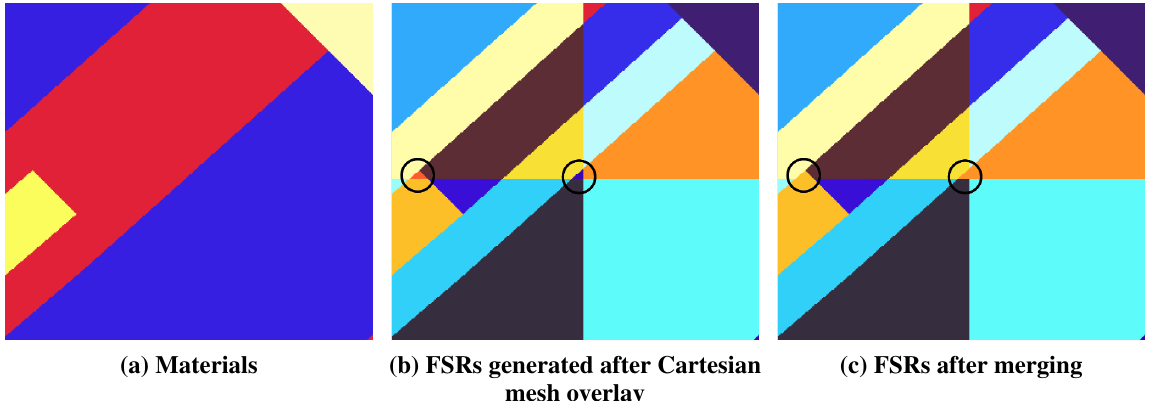
Figure 1: FSR merging process in a fuel plate region of the ATR